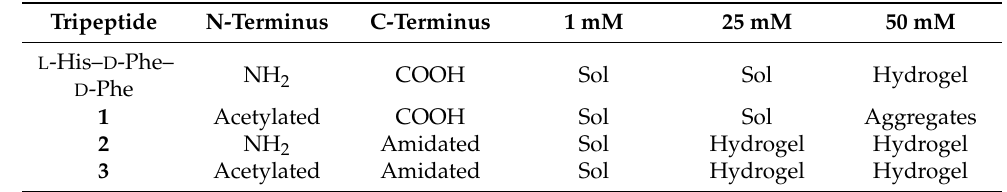
Table 1. Hydrogels were formed by compounds 2 and 3 , but not 1 , in phosphate buffer at neutral pH.